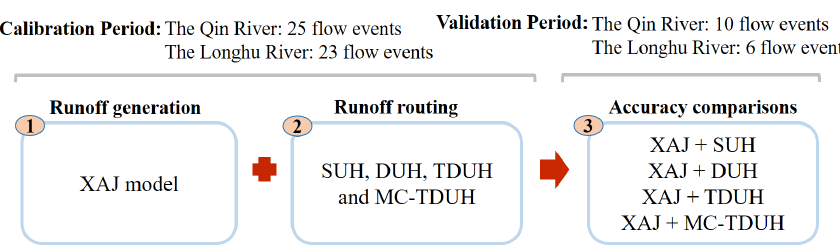
Figure 7. Schematic of the calibration